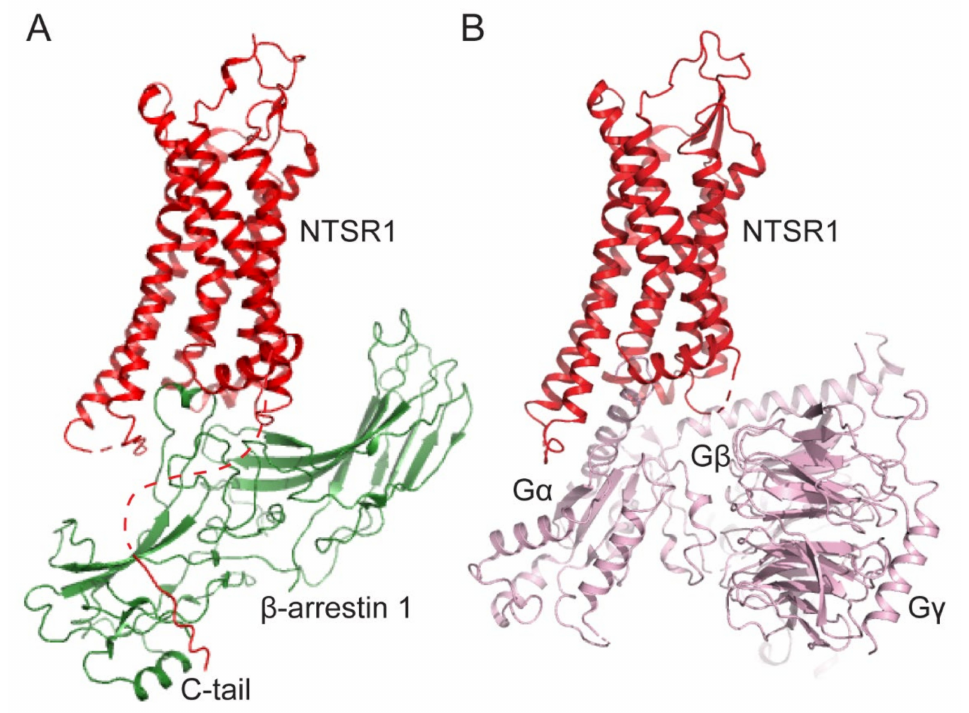
Figure 1. Comparison of GPCR-arrestin and GPCR-G-protein complexes. ( A ) The structure of the neurotensin receptor-1 (NTSR1, red) and β -arrestin-1 (green) complex (PDB: 6UP7). ( B ) The structure of the NTSR1 (red) and heterotrimeric G i1 (light pink) complex (PDB: